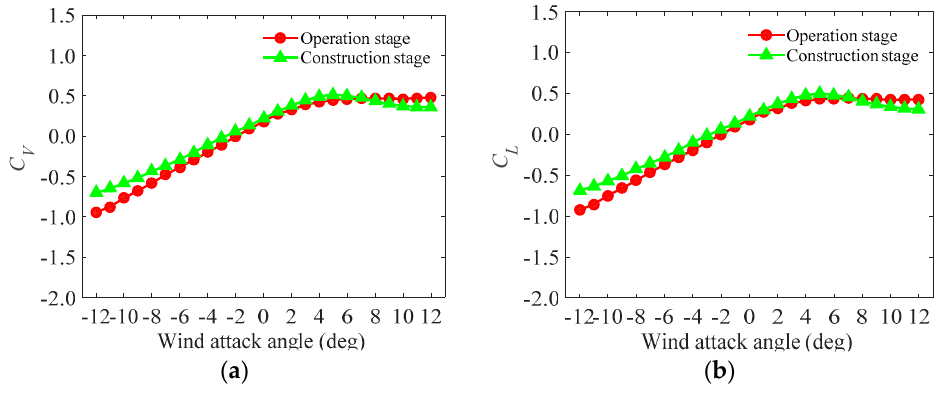
Figure 6. The lift force coefficients of the test models under different wind attack angles: ( a ) in local coordinate system; and ( b ) in global coordinate system.